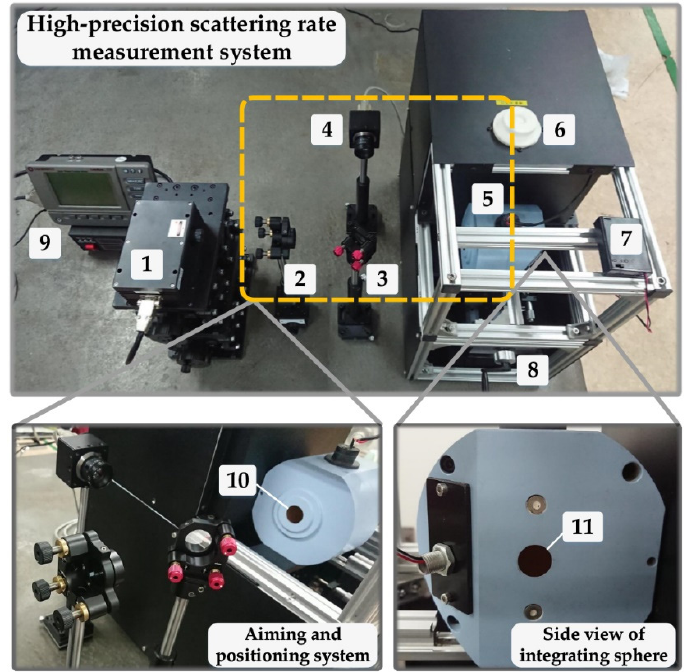
Figure 9. Photograph of high-precision three-hole-integrating-sphere coating-scattering-rate measurement system. (1) laser, (2) optical filter, (3) beam splitter, (4) CCD camera, (5) three-hole integrating sphere, (6) liquid-nitrogen injection port, (7) LED light switch, (8) system frame and three-dimensional adjustment platform of sample, (9) laser power meter, (10) incident beam opening and (11) measuring opening.